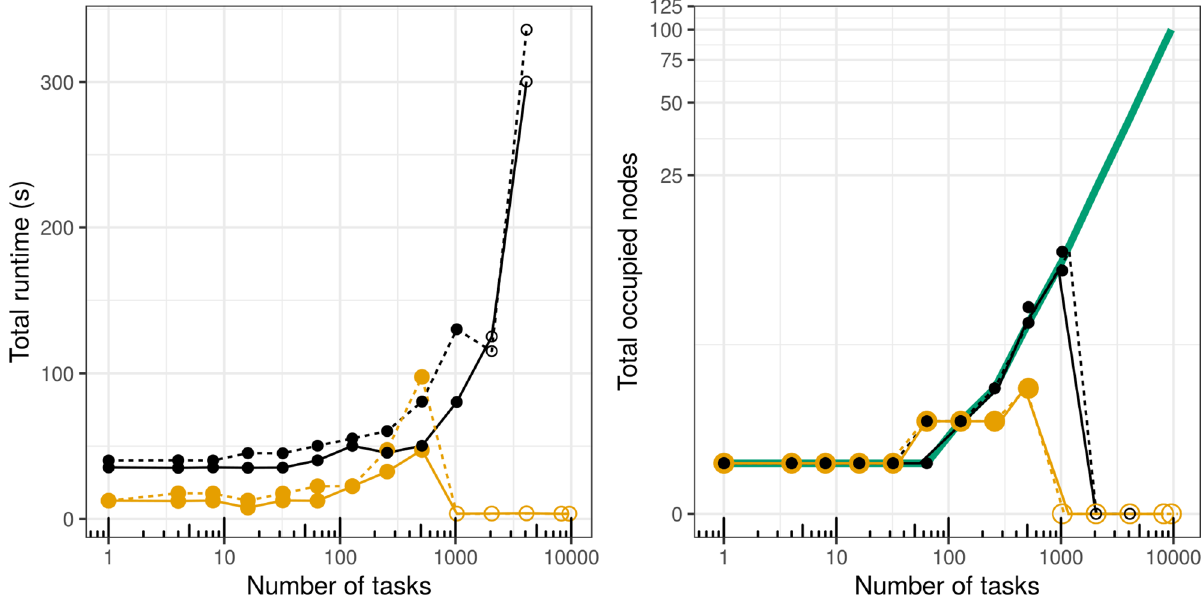
Figure 3. Scaling a one-step (solid line) and two-step (dashed line) workflow in Cromwell+WDL (black) and Nextflow (yellow) on AWS Parallel cluster. The thick green line in the right panel is the theoretical optimum of the number of nodes to be occupied by the tasks, computed as the ceiling of tasks/cores-per-node (96). Empty circles denote failed